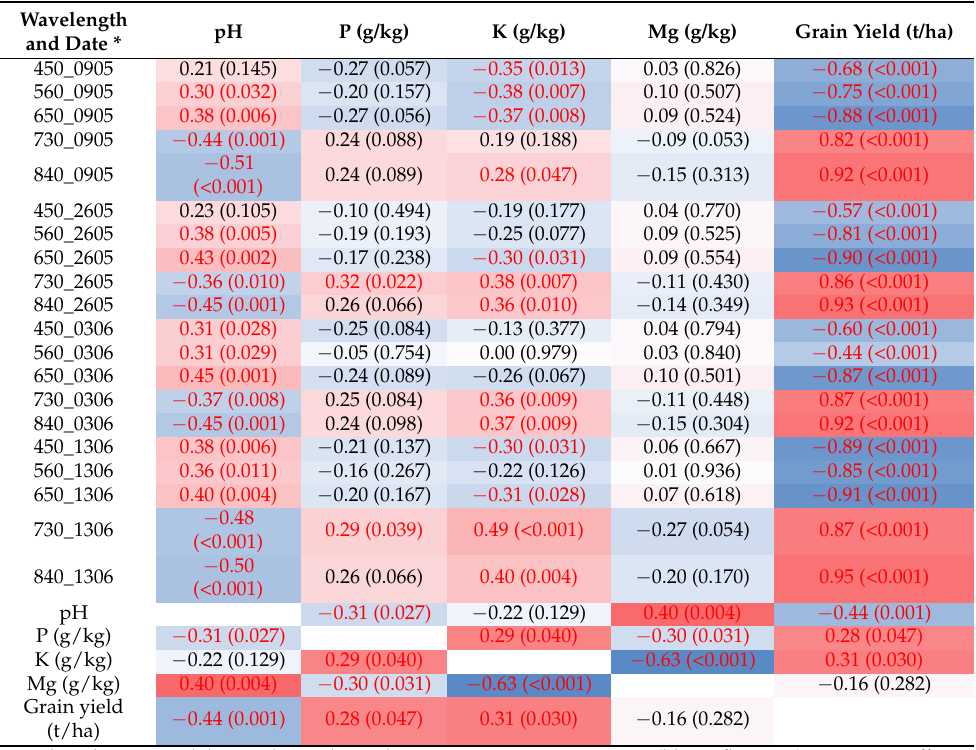
Table 8. Correlation coefficients (and p -values) between spectral reflectance and soil pH, available nutrients, and grain yield for the treatments in experiment 2 (monoculture of rye). Significant correlations ( p < 0.05) are in red